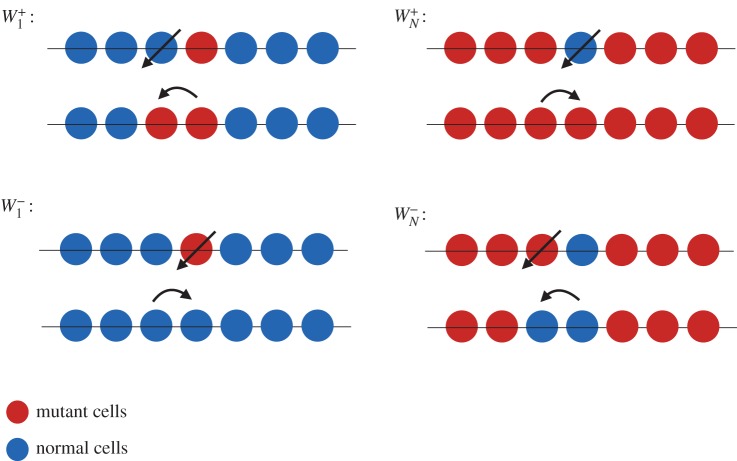
Transition probabilities for the first and last events of fixation. In the text γ1=W−1/W+1 and γN−1=W−N−1/W+N−1. (Figure is depicted for a DB process.)